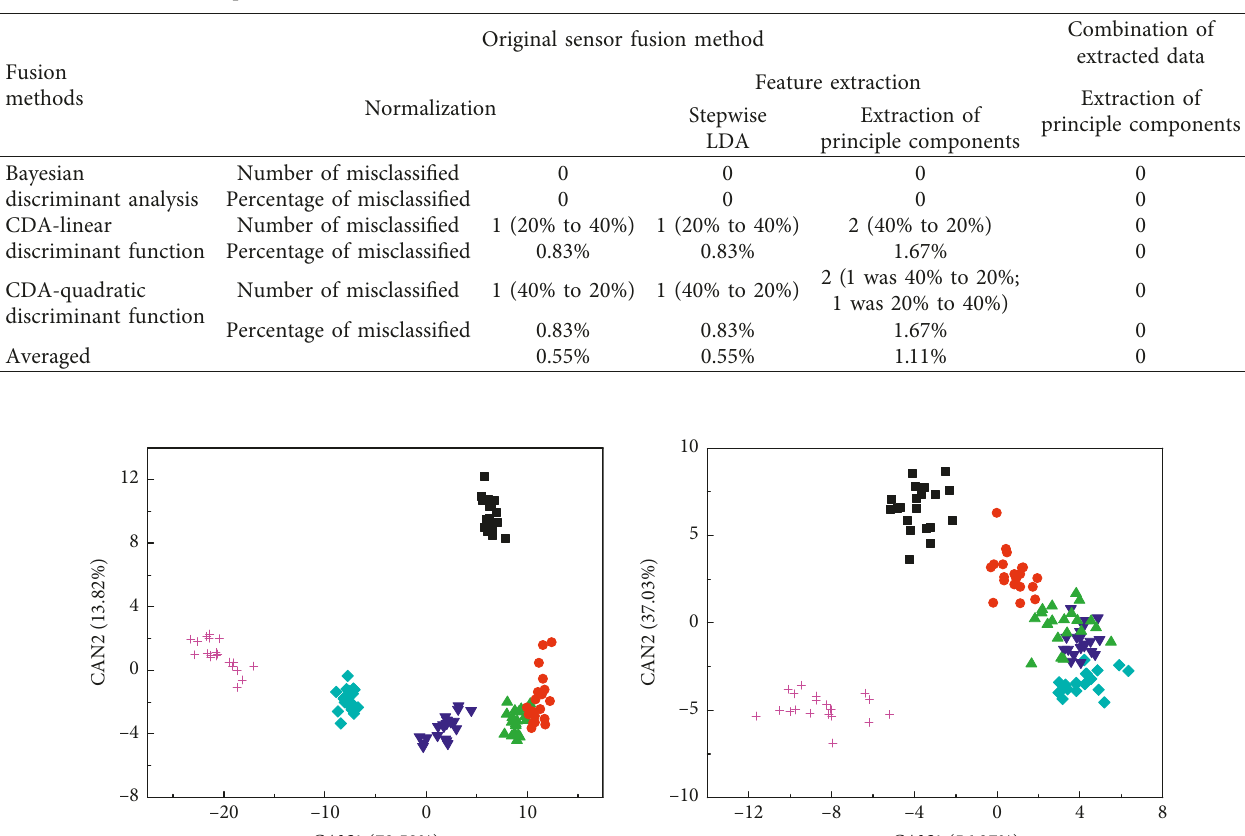
Table 5: Comparison results of discriminant analysis for different data fusion methods for responses of E-nose and E-tongue to minced mutton adulterated with